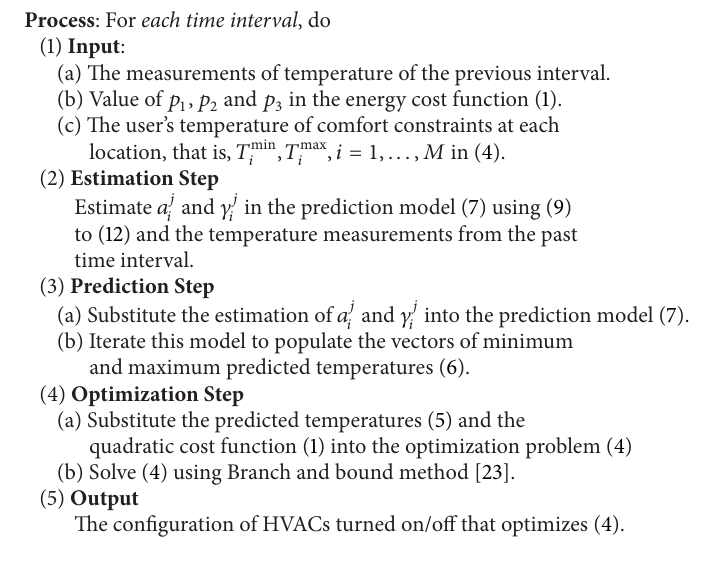
Algorithm 1: Dynamic energy scheduler with comfort constraints